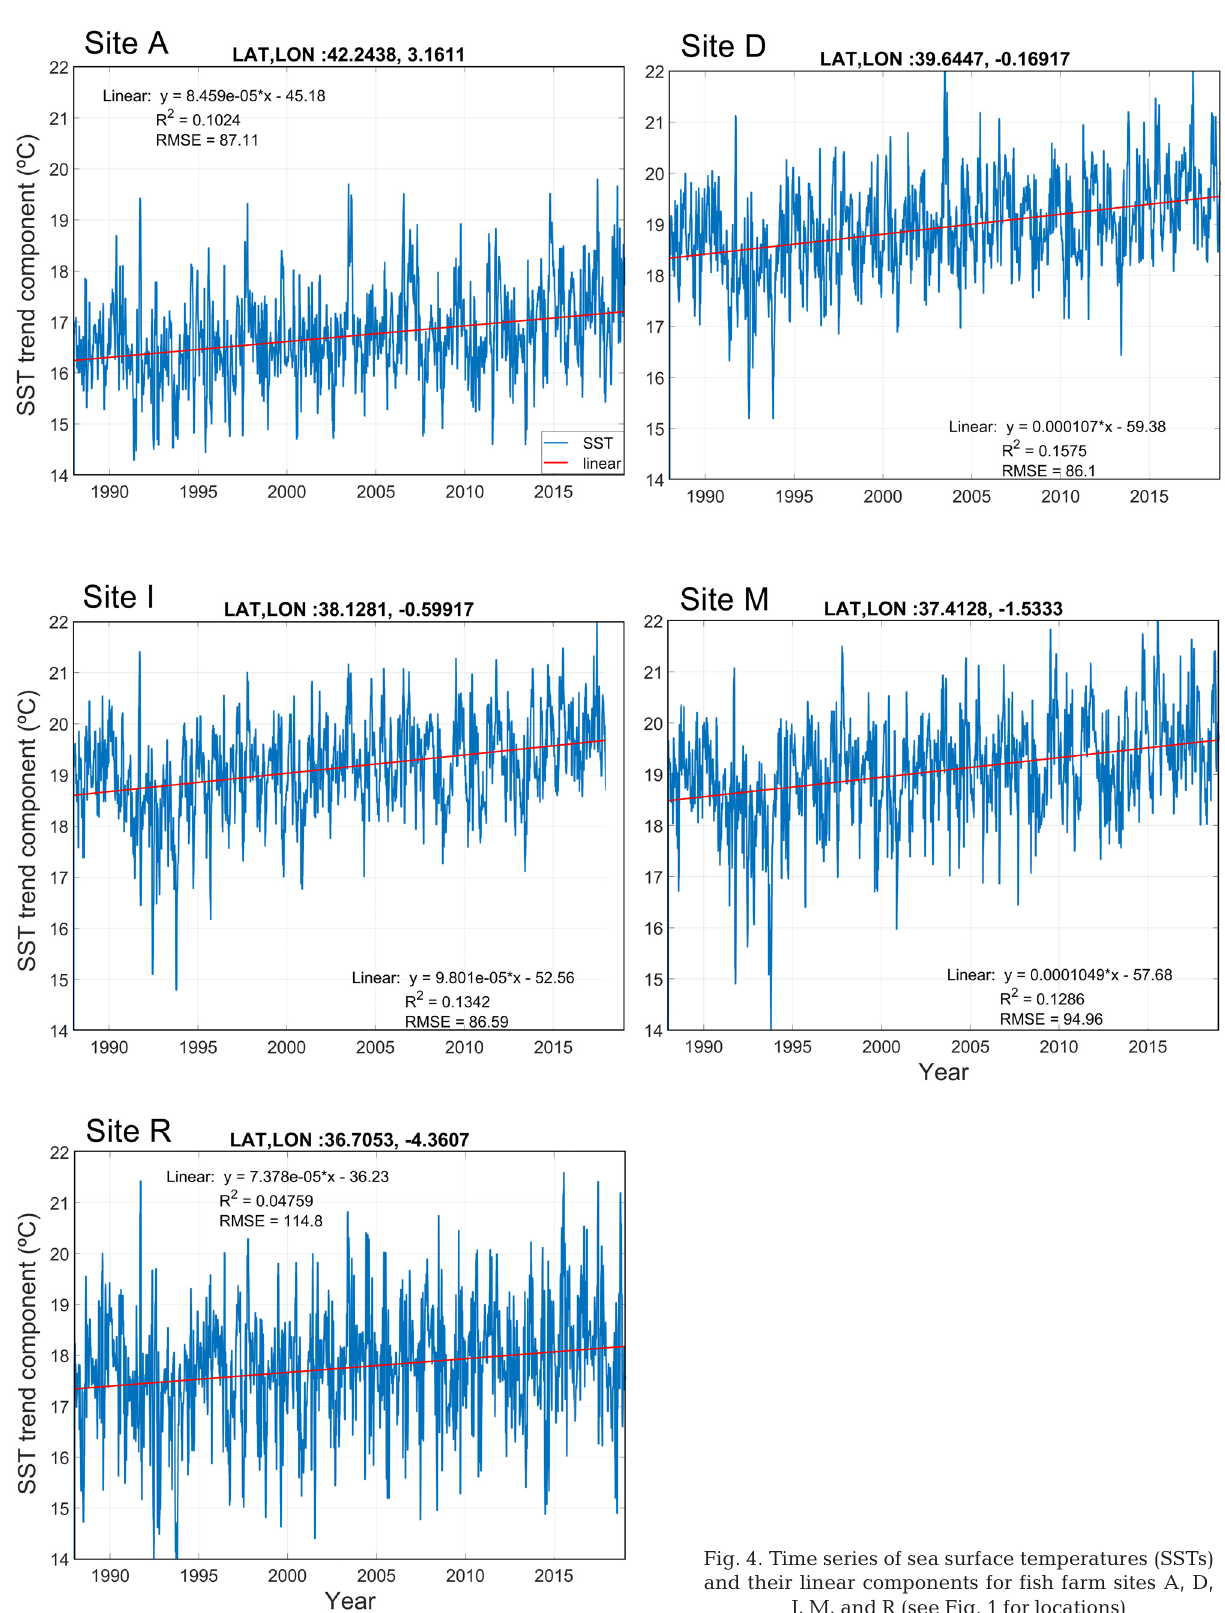
Fig. 4. Time series of sea surface temperatures (SSTs) and their linear components for fish farm sites A, D, I, M, and R (see Fig. 1 for